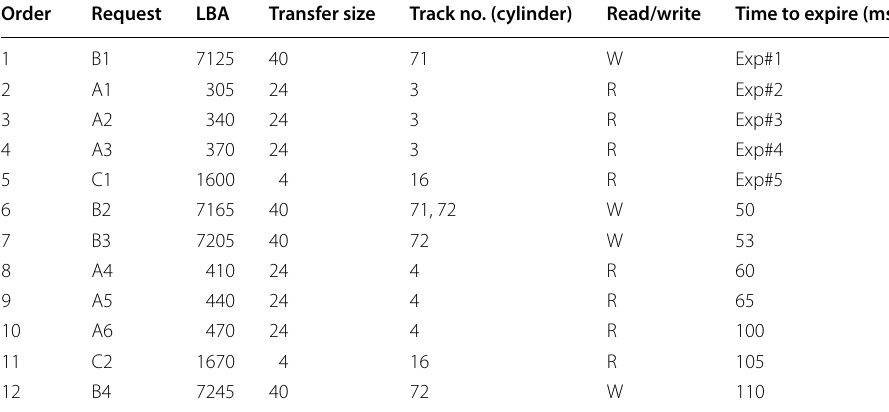
Table 1 I/O request submission order to the block